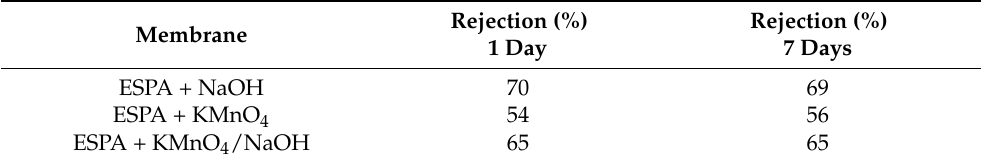
Table 5. Suspended particles rejection of regenerated membranes.